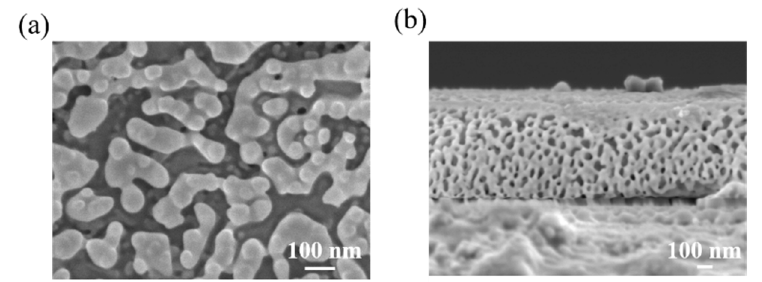
Figure 4. ( a ) Surface morphology and ( b ) cross-sectional image of 2D perovskite growth on a glass substrate 1.23 × 1.23 cm 2 in size achieved by an ODCB/DMF co-solvent and solution processing step.